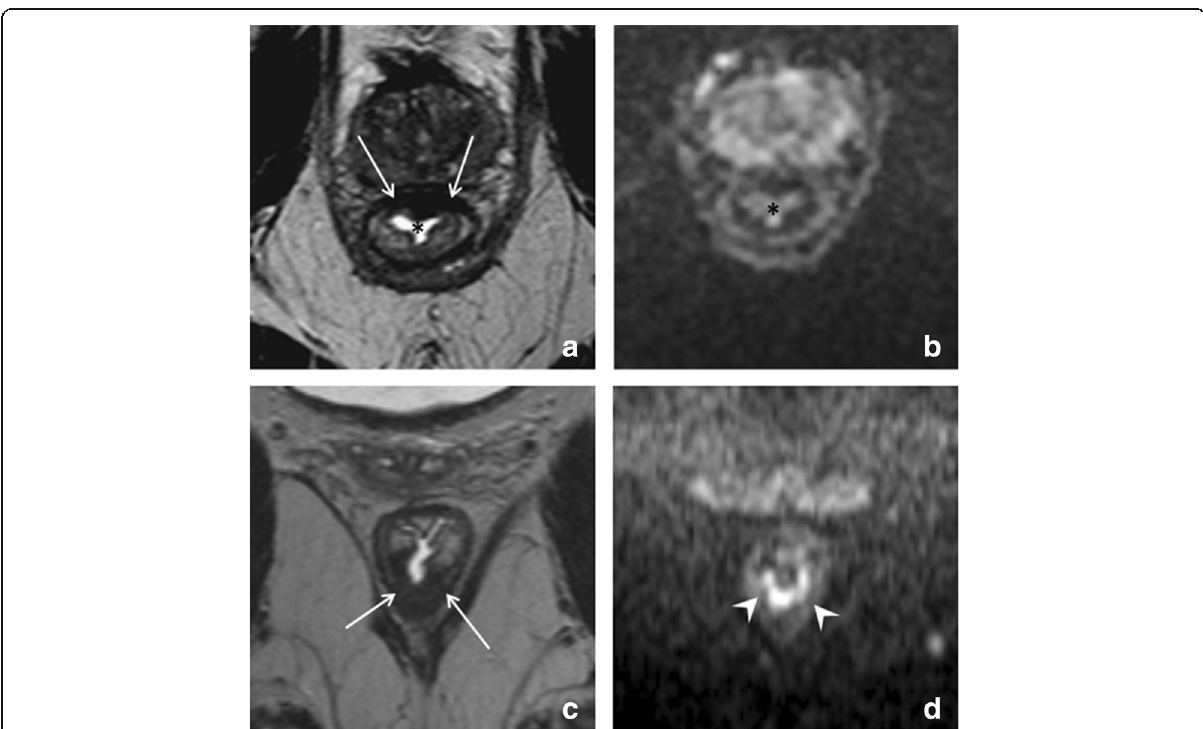
Fig. 7 T2 shine-through. Post-CRT T2-weighted ( a , c ) and diffusion-weighted ( b , d ) images of two male patients who have been treated for low rectal tumors. The upper patient was a complete responder, while the patient in the bottom row still had a ypT2 tumor remnant at histopathology. A very similar fibrotic wall thickening (arrows in a and c ) can be observed in both patients, reflecting the difficulties of T2-weighted MRI to assess response in case of fibrosis. In the upper patient (the complete responder), a star-shaped signal is observed in the rectal lumen (*), representing T2 shine-through of a small amount of fluid present within the rectal lumen. In the lower patient, there is a high signal with a more U-shaped configuration located at the inner margin of the fibrosis (arrowheads in d ), representing the small ypT2 tumor